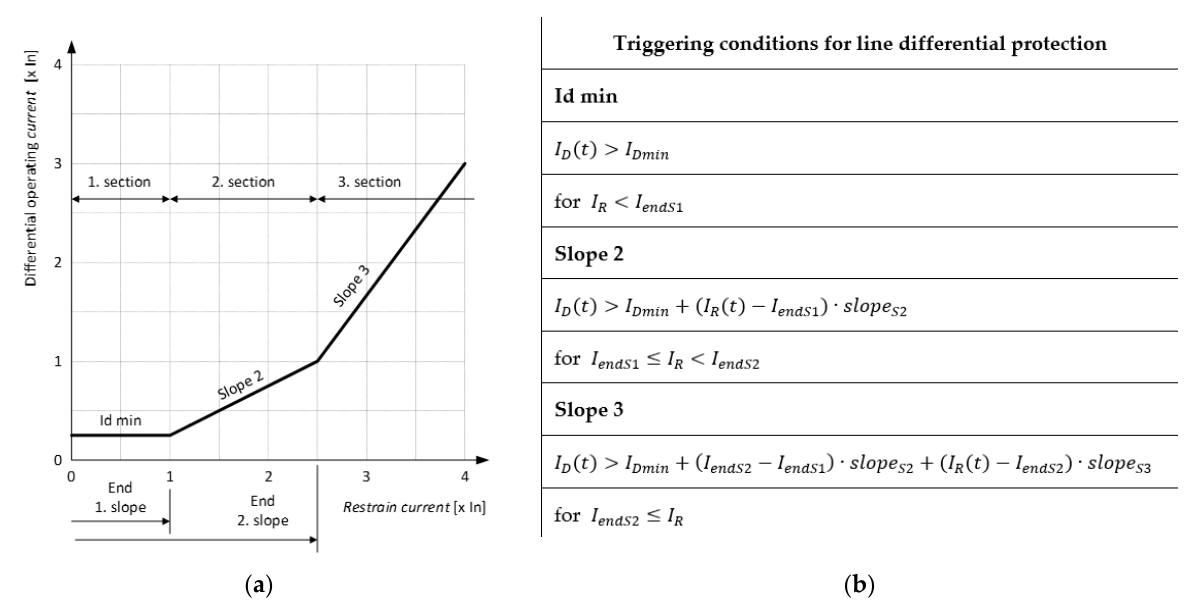
Figure 4. Line differential protection functions based on synchrophasor data: ( a ) operating characteristic for line differential protection; ( b ) conditions for triggering the functions with the differential and restrained current ratio.